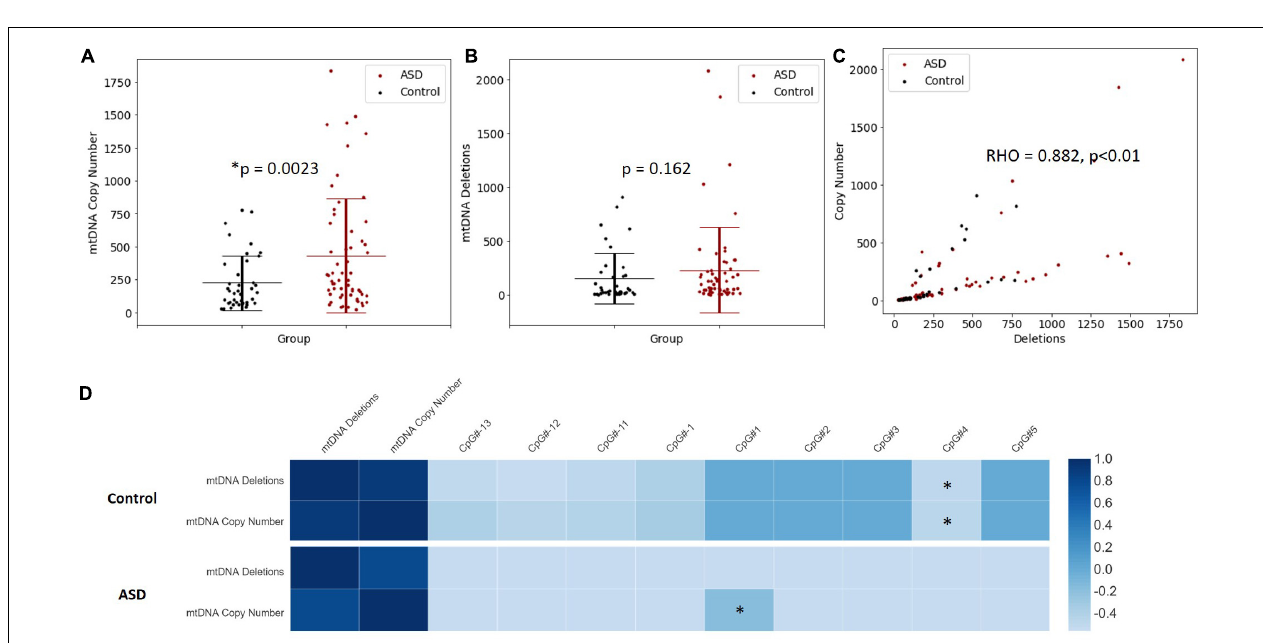
FIGURE 4 | Relationship between mitochondrial DNA (mtDNA) copy number, mtDNA deletion and PGC-1 α promoter methylation. (A) mtDNA copy number is significantly elevated in ASD. Relative quantification of mtDNA copy number was performed by multiplex real-time qPCR of MT-ND1 and B2M (ASD n = 59, controls n = 40). (B) A non-significant increase in mtDNA deletions is observed in ASD. Relative quantification of mtDNA deletion was performed by multiplex real-time qPCR of MT-ND1 and MT-ND4 (ASD n = 59, controls n = 40). Significance was established using Student t -tests where ( p < 0.05). (C) mtDNA copy number correlates significantly with mtDNA deletion in ASD and controls ( n = 99), where Spearman’s rho = 0.882, p < 0.001. (D) The relationship between PGC-1 α promoter methylation, mtDNA copy number and mtDNA deletions is altered in ASD. Heatmap shows Spearman rank correlations between mtDNA deletions, mtDNA copy number and percentage methylation at differentially methylated CpG sites in the PGC-1 α promoter (ASD n = 49, control n = 42). Spearman’s rho is represented according to the color key provided, ∗ indicates p < 0.05. PGC-1 α CpG#1 correlated positively with mtDNA copy number in ASD (Spearman’s r = 0.9, p = 8.814 10-10) while CpG#4 correlated negatively with both mtDNA copy number and (Spearman’s r = –0.4, p = 0.045) and mtDNA deletions (Spearman’s r = –0.4, p = 0.032) in